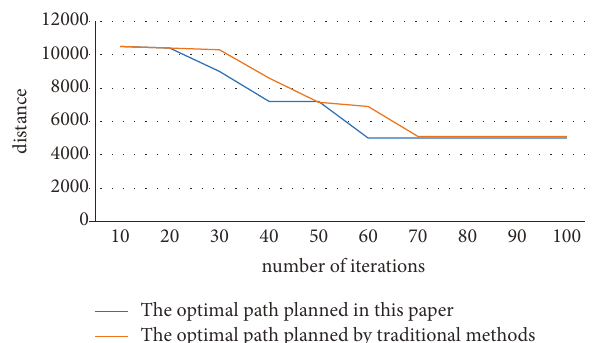
Figure 6: The path change diagram is improved by the two